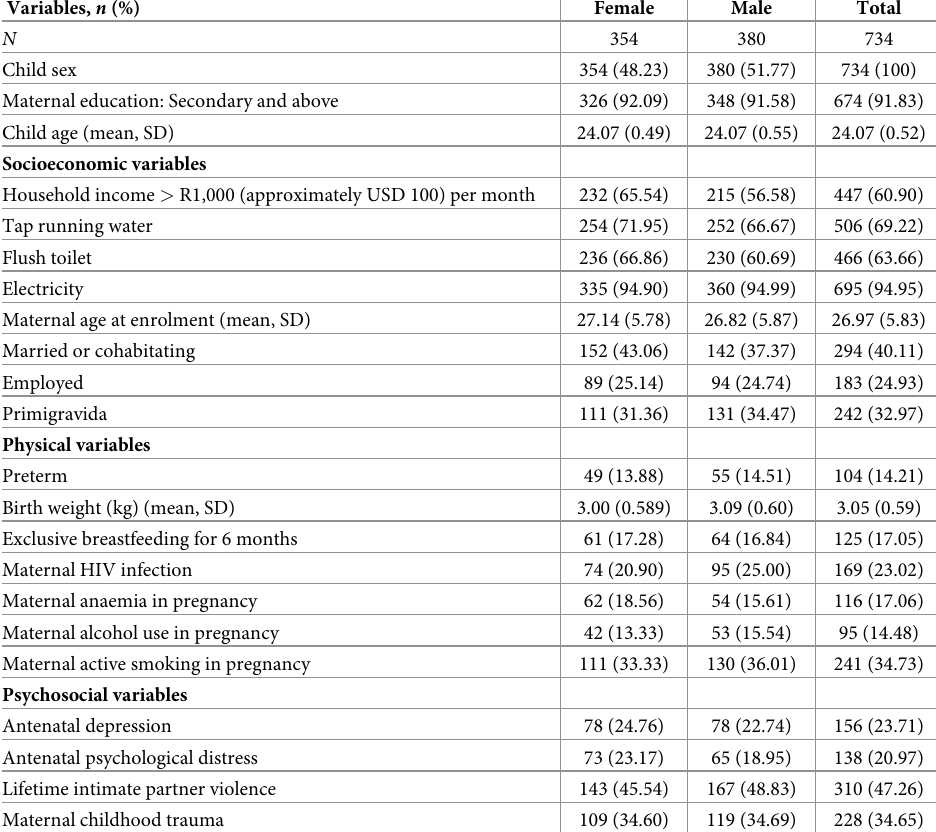
Table 1. Demographics and baseline characteristics for those children completing at least one domain of the BSID-III. Variables, n (%) Female